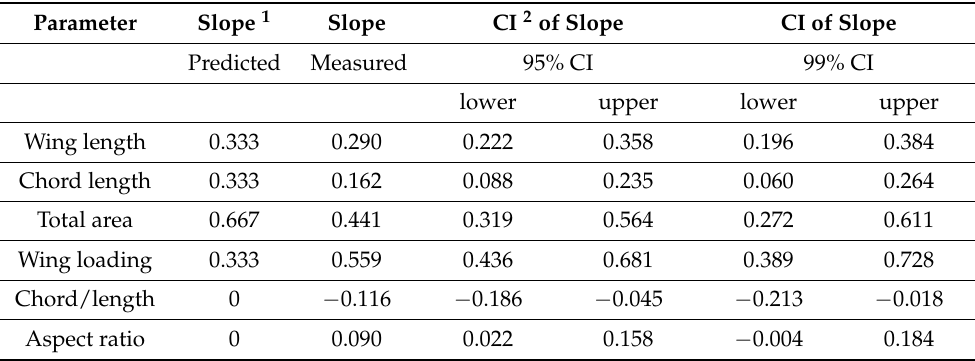
Table 2. Scaling of parameters measured in T.f.pratincola and T.f.punctatissima .